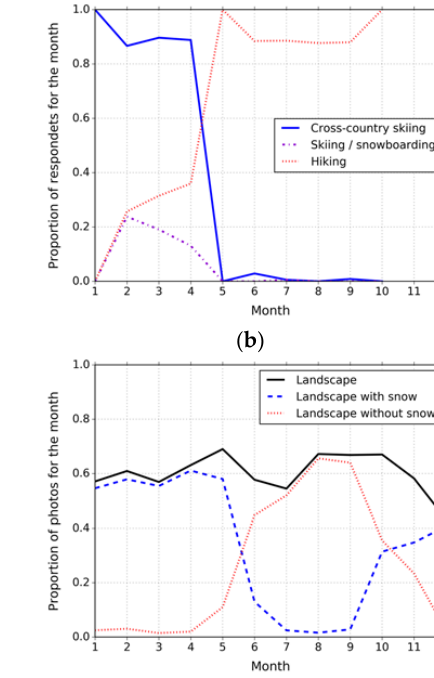
Figure 5. Temporal comparison of official visitor information and social media content: ( a ) Official visitor counts and active daily users in Instagram; ( b ) most popular activities in the visitor survey; ( c ) most popular activities in the social media data; ( d ) landscape photos with and without snow.